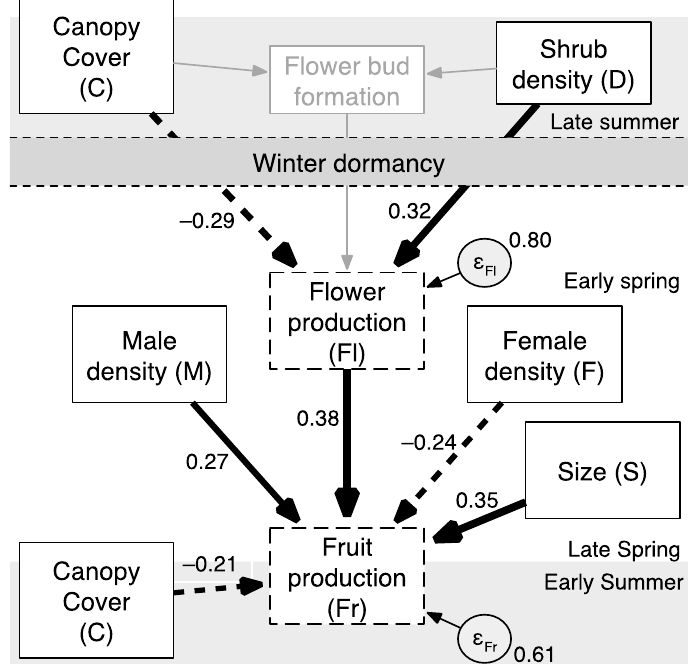
Figure 2. Model describing the e ff ect of light availability (% canopy cover), plant (male, female, and total) density, shrub size (m), and flower production (# / cm of branch) on total fruit production of Shepherdia canadensis in Central Alberta, Canada. Figures beside each path indicate direct e ff ects reported as standardized coe ffi cients. Dashed paths indicate negative coe ffi cients. Indirect e ff ects are not displayed (see Table 2). Dashed rectangles indicate endogenous variables. “Density (F)” and “Density (M)” represent density of female and male plants surrounding the focal female shrub, respectively. “Density (D)” indicates the aggregate (total) male and female density surrounding the focal female shrub. Grey paths and rectangle surrounding flower bud formation indicate theorized phenological paths [22], while all black arrows and rectangles indicate measured variables and estimated path